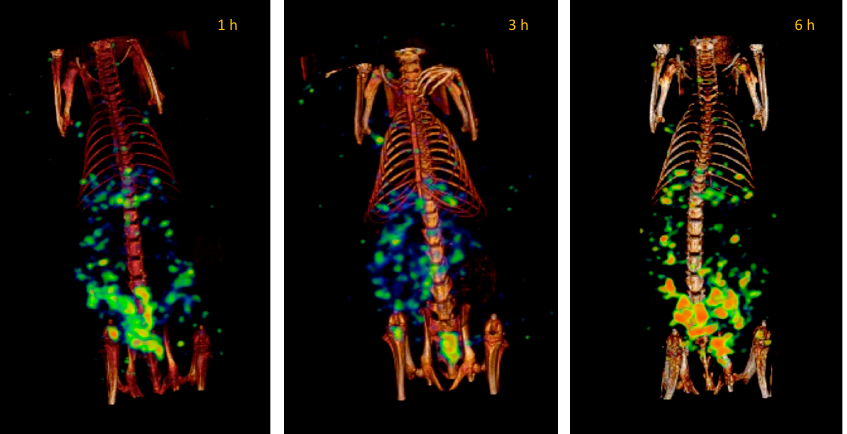
Figure 11. Representative SPECT/CT images of the PEG lipomics’ biodistribution at 1, 3, and 6 h after injection in healthy rats. Images are from the same rat.